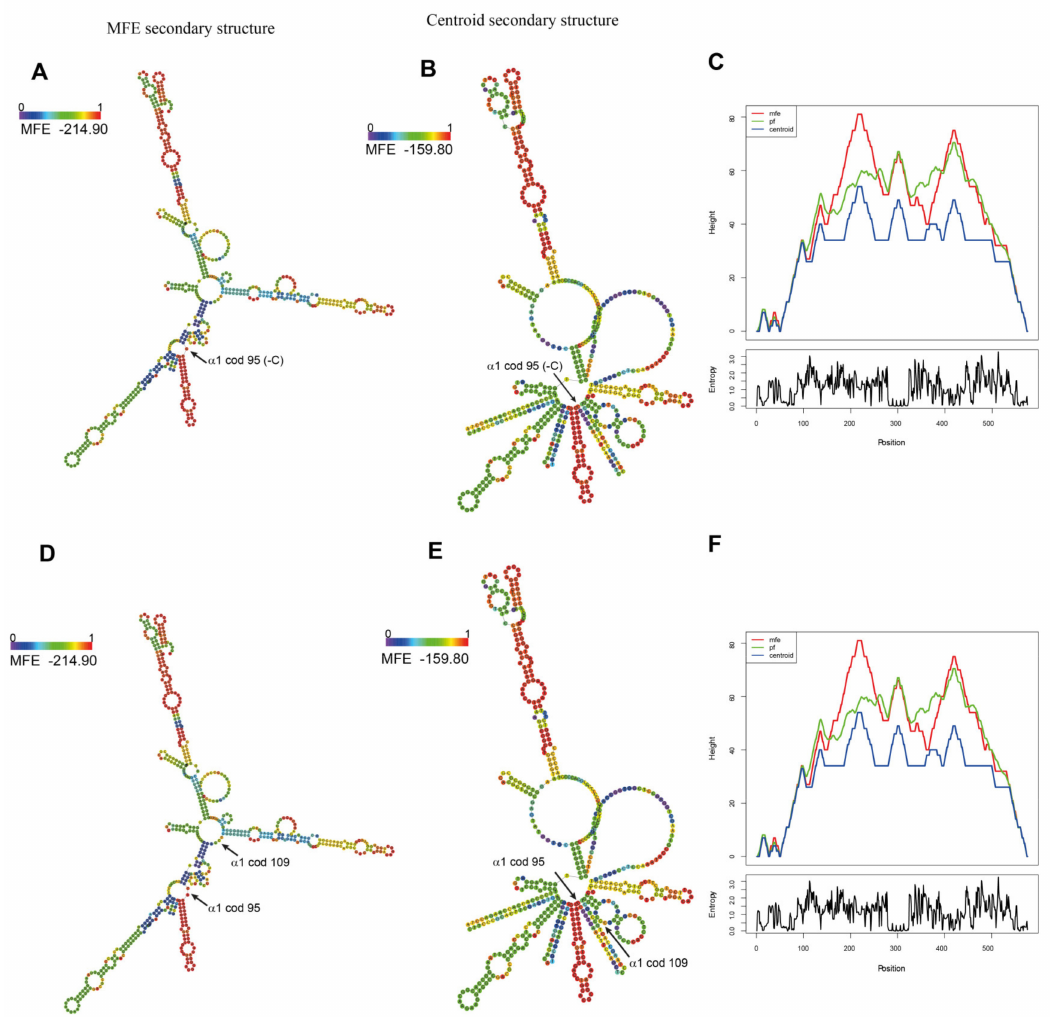
Figure 3. Secondary structure of α 1-globin mRNAs predicted by the RNAfold web server. ( A , B , C ) α 1 cod95 ( − C) mRNA. ( D , E , F ) WT α 1-globin mRNA. ( A , D ) Minimum free energy (MFE) secondary structure. ( B , E ) Centroid secondary structure with the corresponding values. ( C , F ) Mountain plot representation of the MFE structure for each α 1-globin mRNA. The values of α 1 cod95 ( − C) were comparable with the values of WT α 1